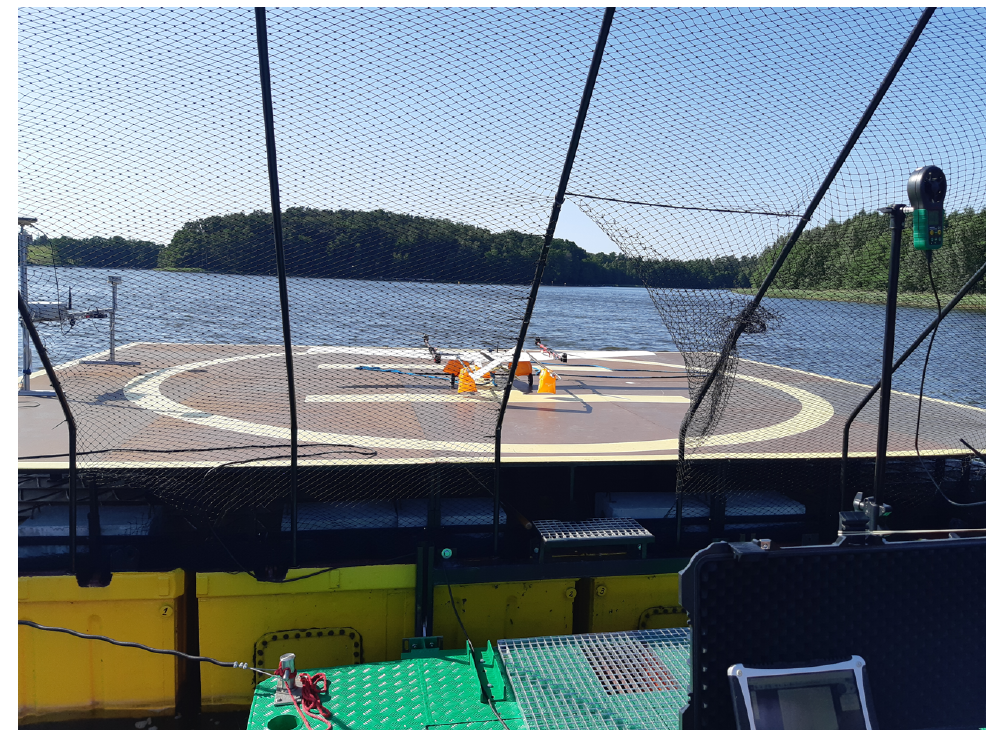
Figure 3. Albatross VTOL UAV during tests in quasi-real conditions on a